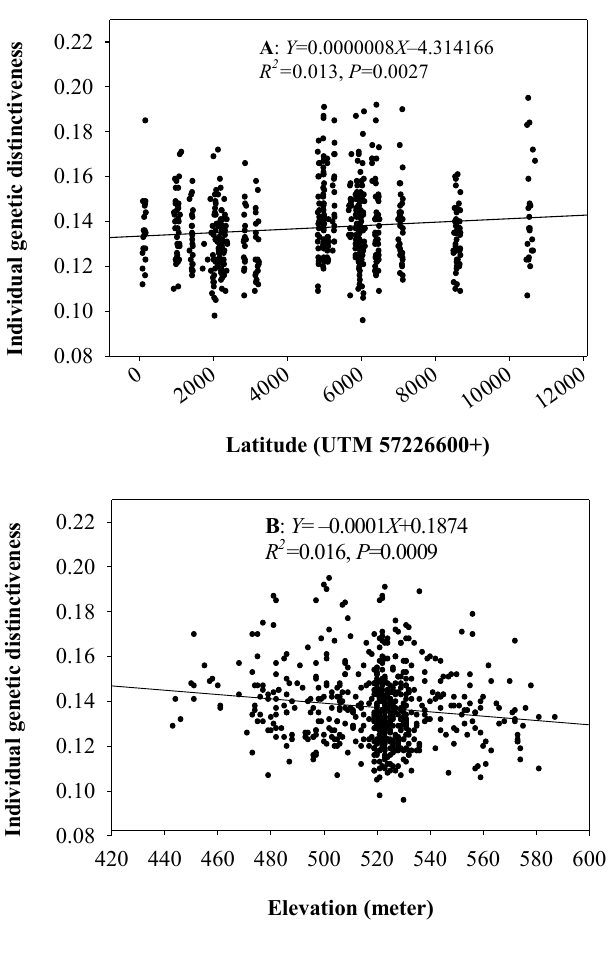
Figure 4. Correlation analysis among the genetic distinctiveness estimates of individual hairy prairie-clover plants, site latitude ( A ) and elevation ( B